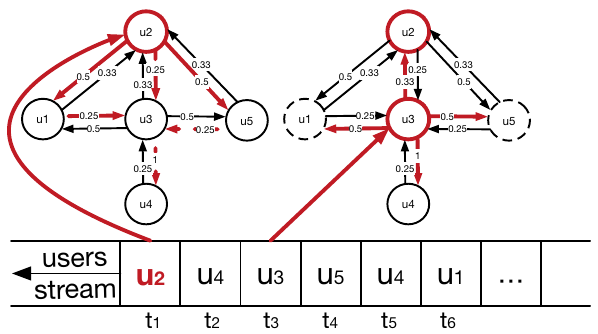
Fig. 2 Ex. of the live stream ( T ) of available